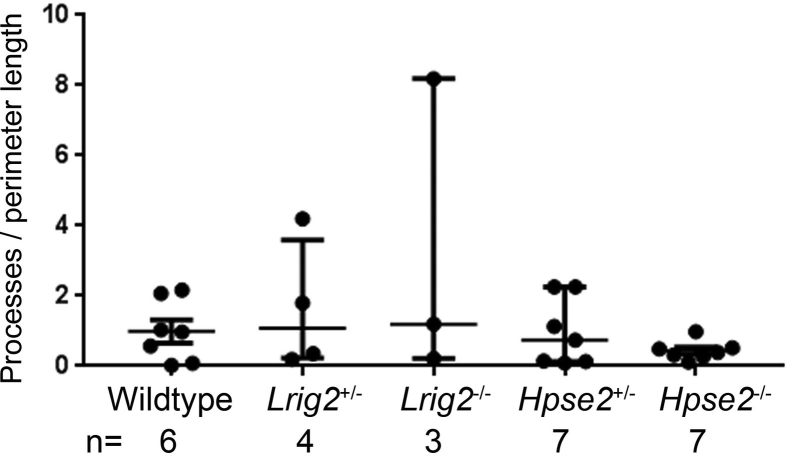
Quantification of processes emanated from pelvic ganglia explants. Fragments of embryonic pelvic ganglia were explanted and the numbers of processes that had emanated from them were counted after 1 day in culture. Results are shown as median and ranges, with values factored for the length of the perimeter in each explant. The wild-type median was defined as “1.” There were no significant differences (all P > 0.05) between wild-type explants and either leucine-rich repeats and Ig-like domains 2 (Lrig2) or heparanase 2 (Hpse2) mutants as assessed by Kruskal-Wallis tests. The number of ganglia assessed are shown in the figure.